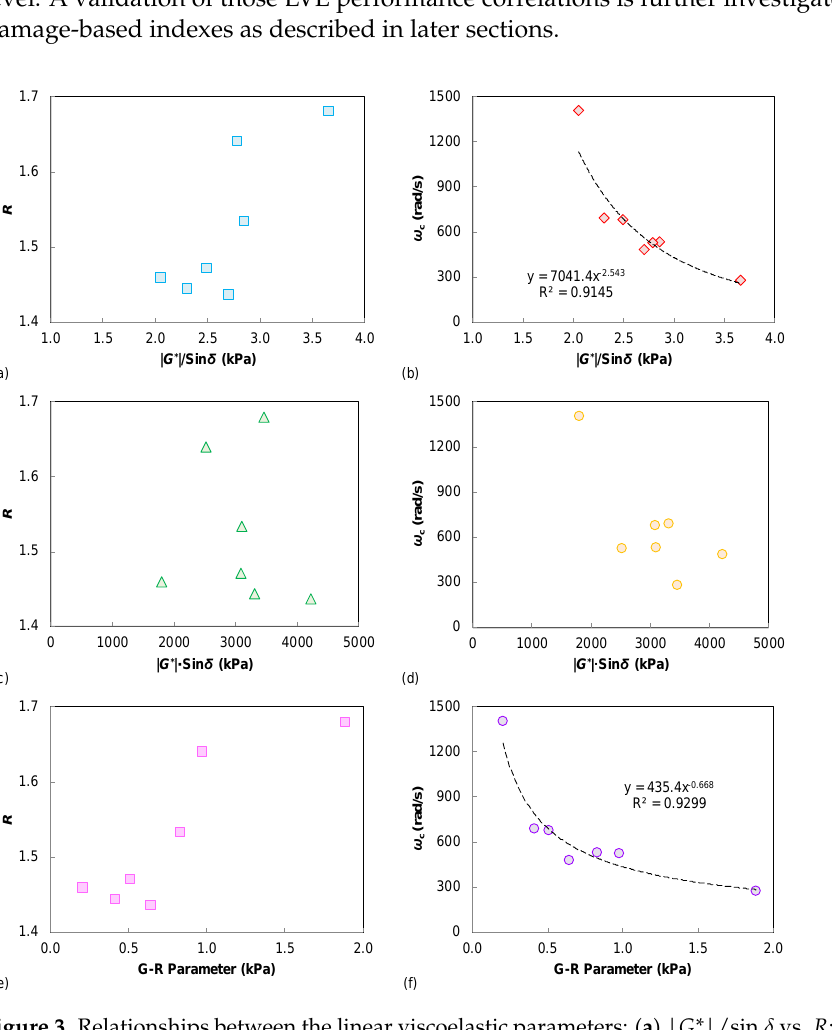
Figure 3. Relationships between the linear viscoelastic parameters: ( a ) | G* |/sin δ vs. R ; ( b ) | G* |/sin δ vs. ω c ; ( c ) | G* | · sin δ vs. R ; ( d ) | G* | · sin δ vs. ω c ; ( e ) G-R parameter vs. R ; ( f ) G-R parameter vs. ω c .